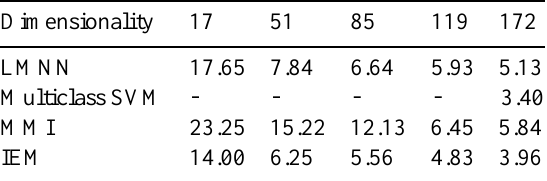
Table 1. Benchmark test error rates on Isolet